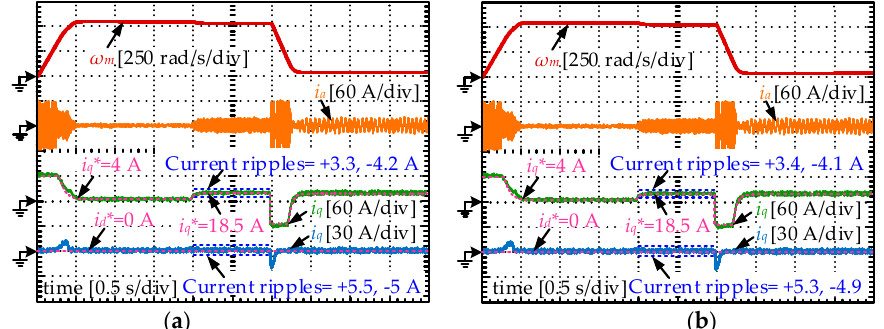
Figure 13. Experimental results of the proposed FCS-MPCC method under different resistance and inductance disturbances: ( a ) L 0 = 2 L , ∆ L = − L , R s0 = R s , ∆ R s = 0; ( b ) L 0 = L , ∆ L = 0, R s0 = 5 R s , ∆ R s = − 4 R s .